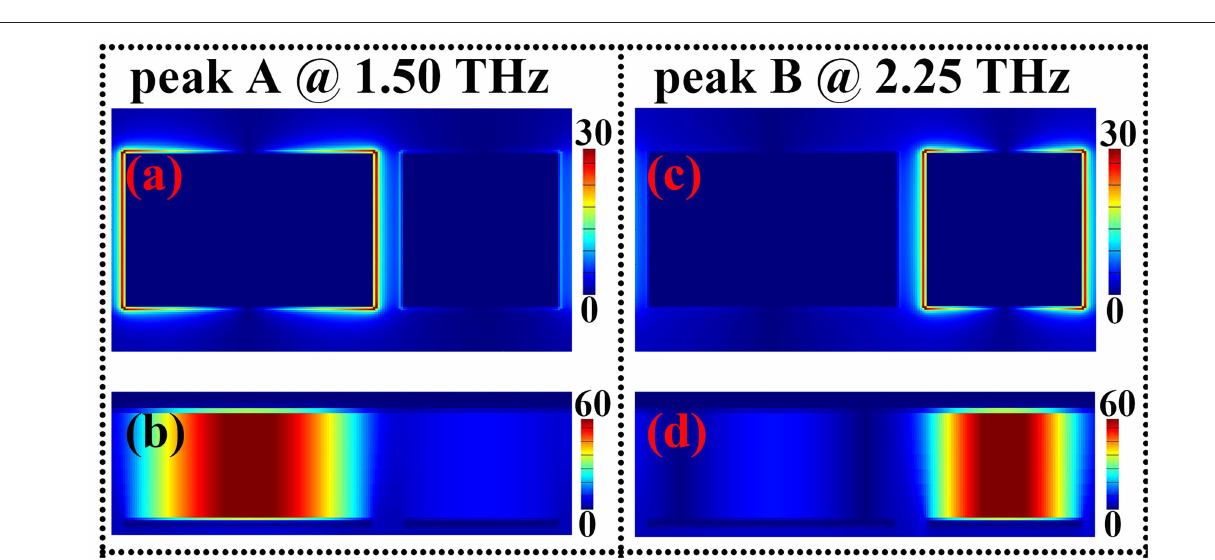
FIGURE 4 | Panels (A,B) are respectively the electric and magnetic field patterns of the absorption peak A at 1.50 THz; (C,D) are respectively the electric and magnetic field patterns of the absorption peak B at 2.25